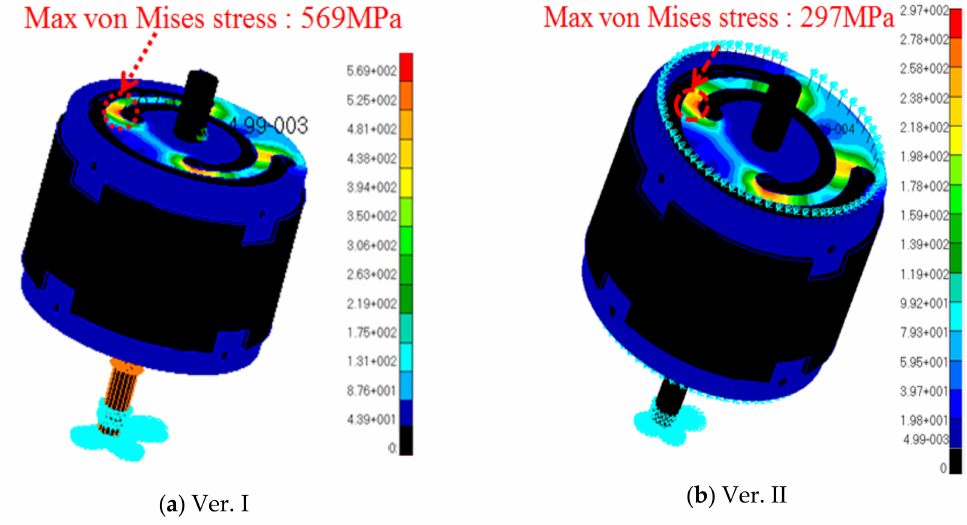
Figure 10. Stress contours of VEH through frequency response analysis. Table 3. Relative error of frequency response analysis results with experimental results